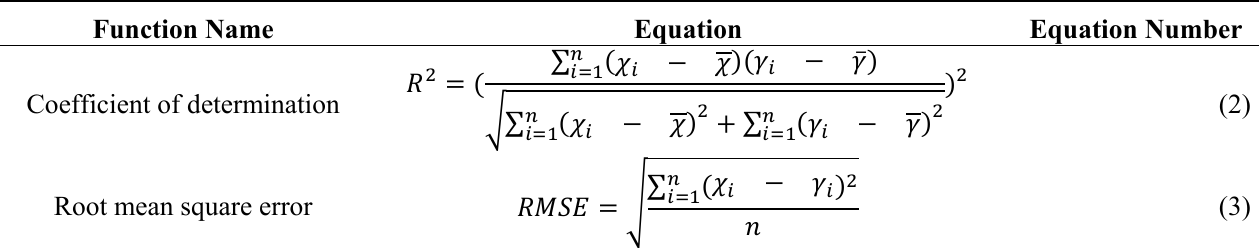
Table 1. Statistical criteria for evaluating the regression